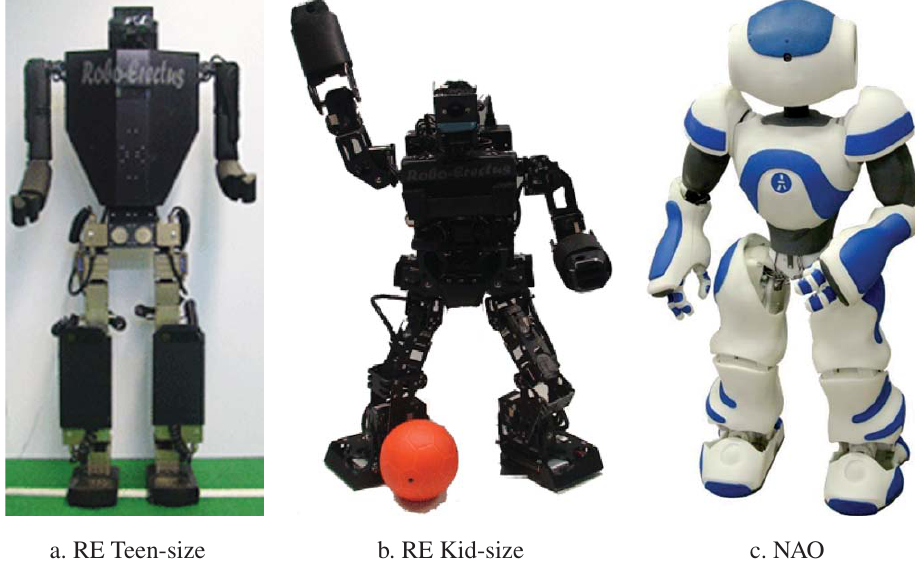
Fig. 1. RoboErectus and NAO humanoid